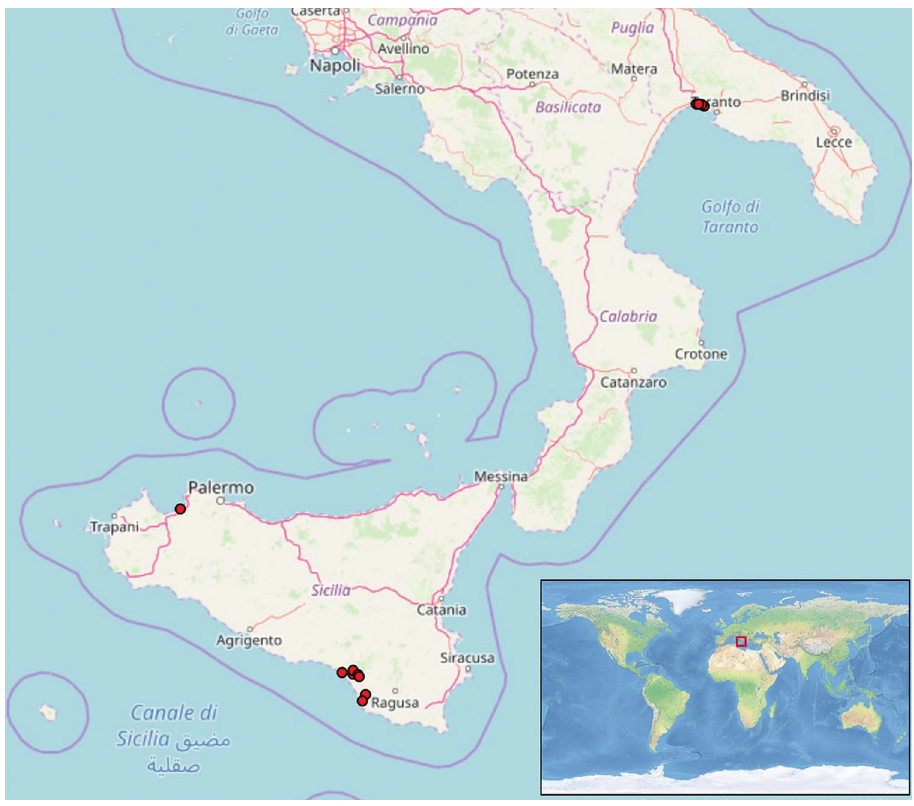
Figure 6. Geographic range and distribution map of Helianthemum lippii in Sicily and